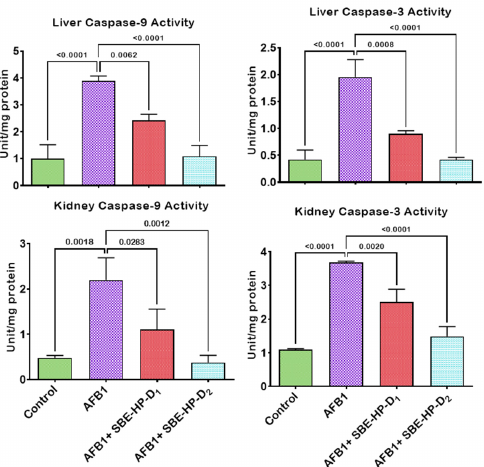
Figure 9. E ff ect of SBE-HP on tissue concentrations of IL-1 β and IL-10 in the liver and kidney of rats treated with AFB 1 for 28 d. AFB 1 at 50 µg/kg; SBE-HP-D1 at 5 mg/kg; SBE-HP-D2 at 10 mg/kg. Values are expressed as mean ± SD for six rats per treatment cohort. Connecting lines indicate groups compared to one another. The signi fi cance level was set at (p < 0.05 ) ; p < 0.05 suggests the level of signi fi cance; p > 0.05: not signi fi cant. AFB 1 : A fl atoxin B1; D1: lower dose; D2: higher dose; IL-1 β : Interleukin-1beta; IL-10: Interleukin-10.